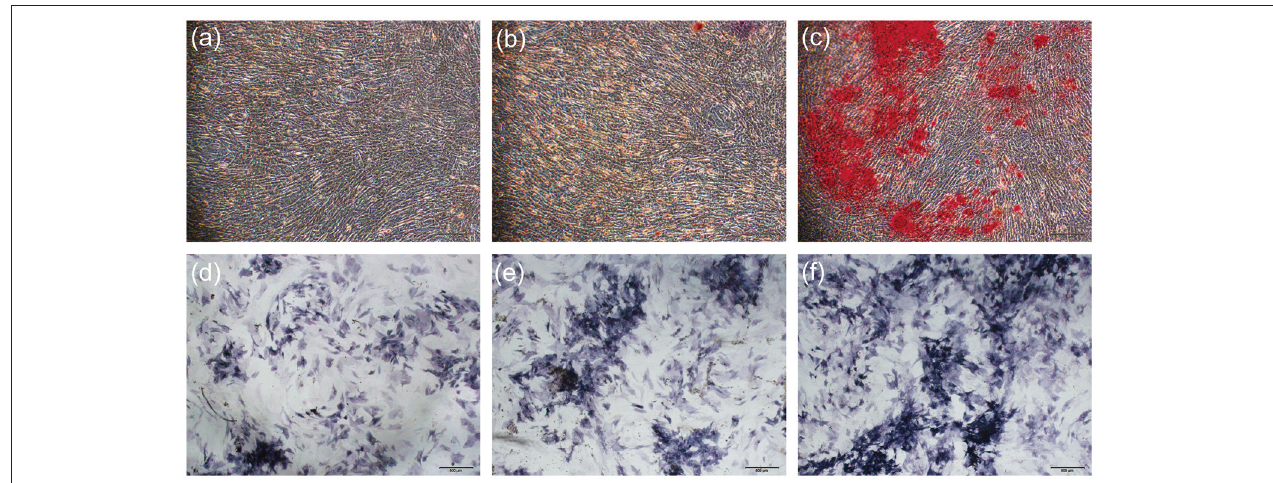
FIGURE 8 | (a) Alizarin red staining of blank group. (b) Alizarin red staining of HA 0 (SA/CS) 10 @VEGF/VAN scaffold. (c) Alizarin red staining of HA 6 (SA/CS) 4 @VEGF/VAN scaffold. (d) Results of intracellular ALP activity expression in blank group. (e) Results of intracellular ALP activity expression in HA 0 (SA/CS) 10 @VEGF/VAN scaffold. (f)